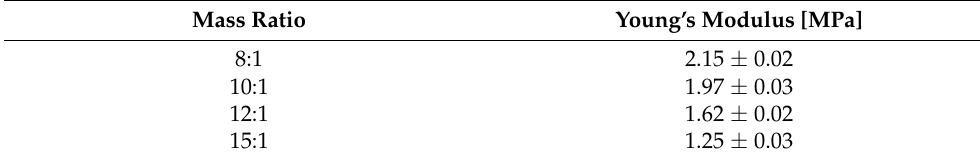
Table 2. Young’s modulus of solidified PDMS with different mass ratios. Mass